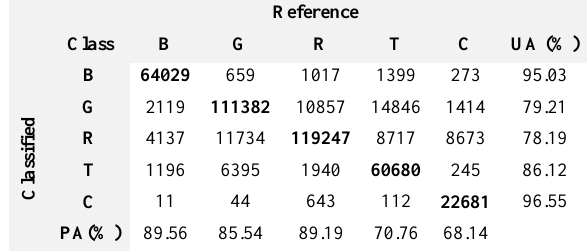
Table 3. Confusion Matrix of the proposed CNN classifier.